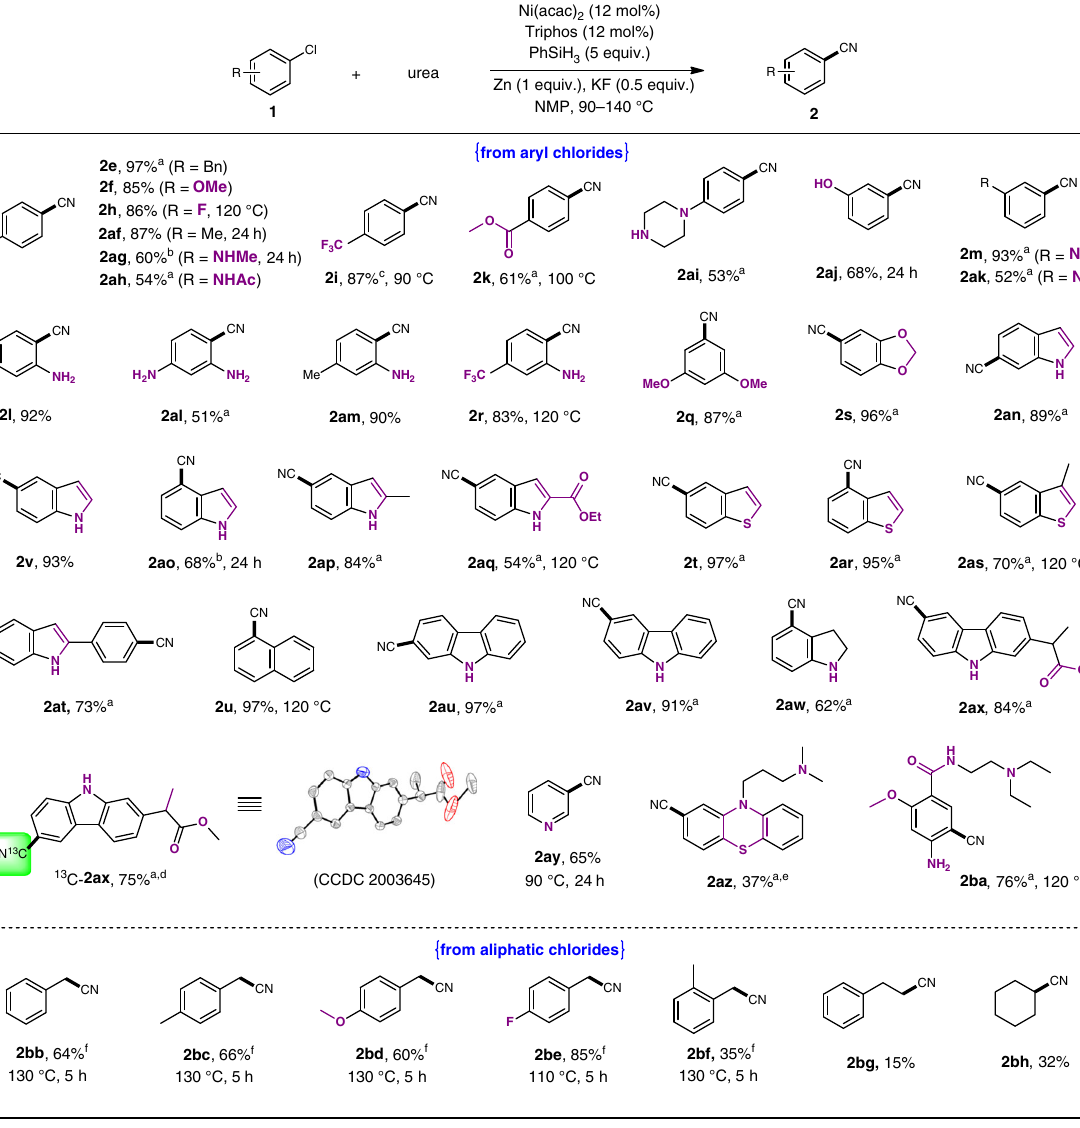
Fig. 6 Substrate scope using urea. Reaction conditions: 1 (0.3mmol), urea (3 equiv.), NMP (1.0mL), 20h; GC yield. a Isolated yields. b 15mol% Ni(acac) 2 , 15mol% Triphos. c K 3 PO 4 was used instead of KF. d13 C-urea was used. e From chlorpromazine hydrochloride, 1.5 equiv. KF. f dppp was used instead of Triphos.